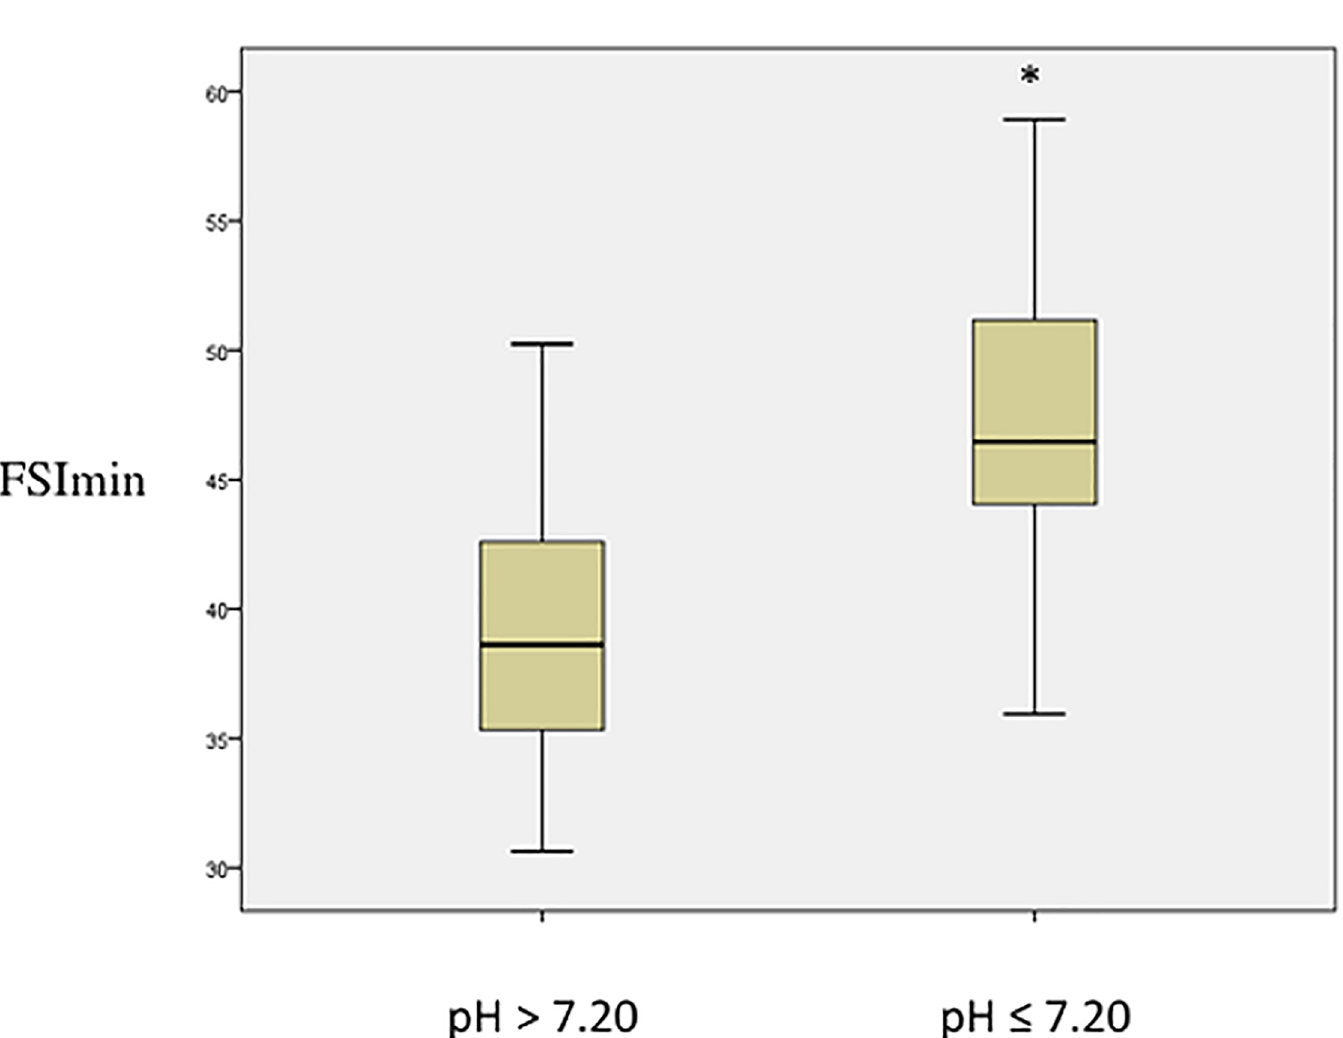
Fig 1. Fetal Stress Index according to pH. FSI min according to pH during occlusion (n = 8). The data are presented as median ± interquartile. (cid:3) : p < 0.05 versus pH > 7.20. https://doi.org/10.1371/journal.pone.0190463.g001 PLOS ONE | https://doi.org/10.1371/journal.pone.0190463 January 10,